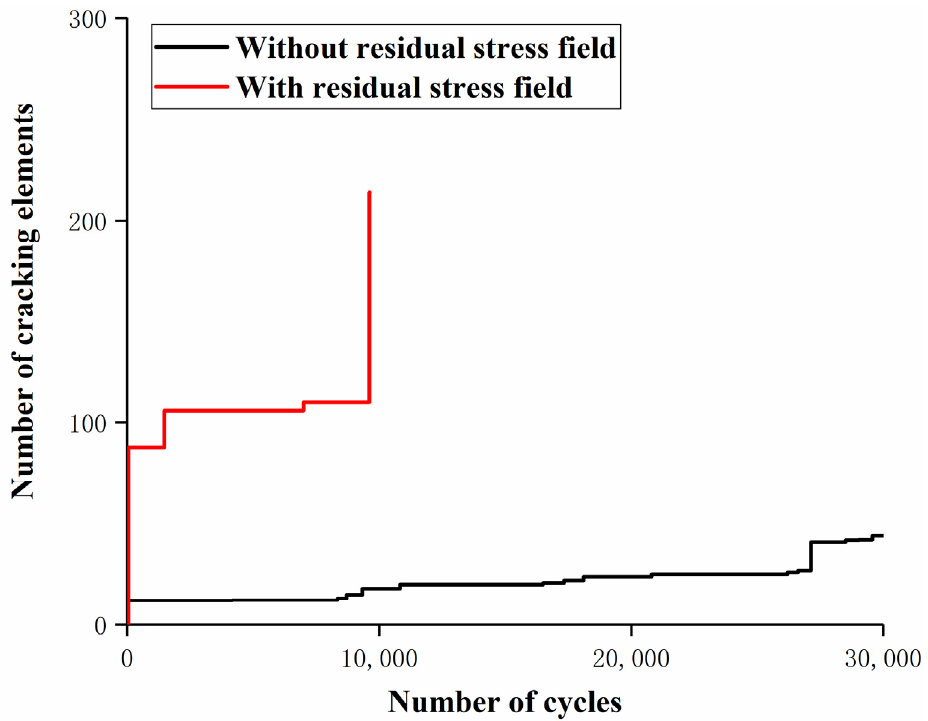
Figure 21. Relationship between the number of cracked elements and number of load cycles for with a maximum displacement load of 0.4 mm.